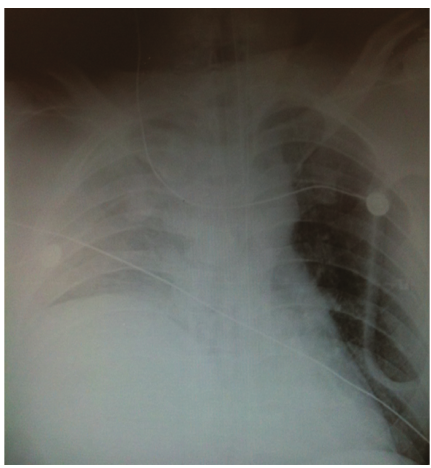
Figure 1: Chest X-ray on arrival to trauma bay.